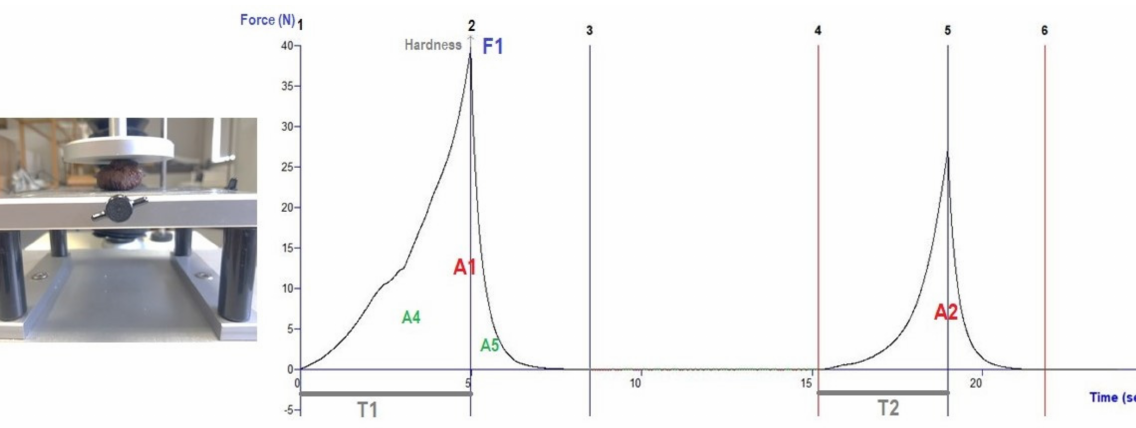
Figure 6. Texture analysis: curve force versus time for compression test